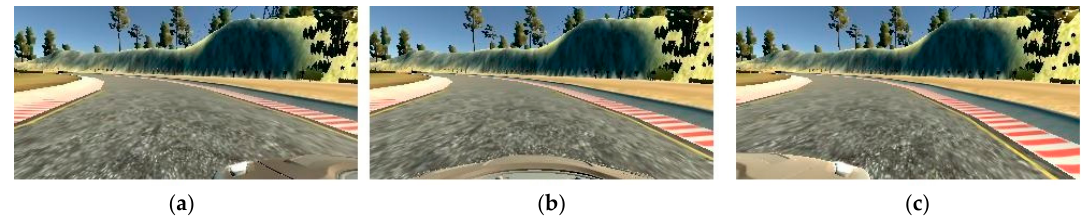
Figure 9. Example of data collection taken simultaneously using the three cameras mounted on the vehicle: ( a ) left; ( b ) center; ( c ) right camera. This is an example of images captured in the very first frame.